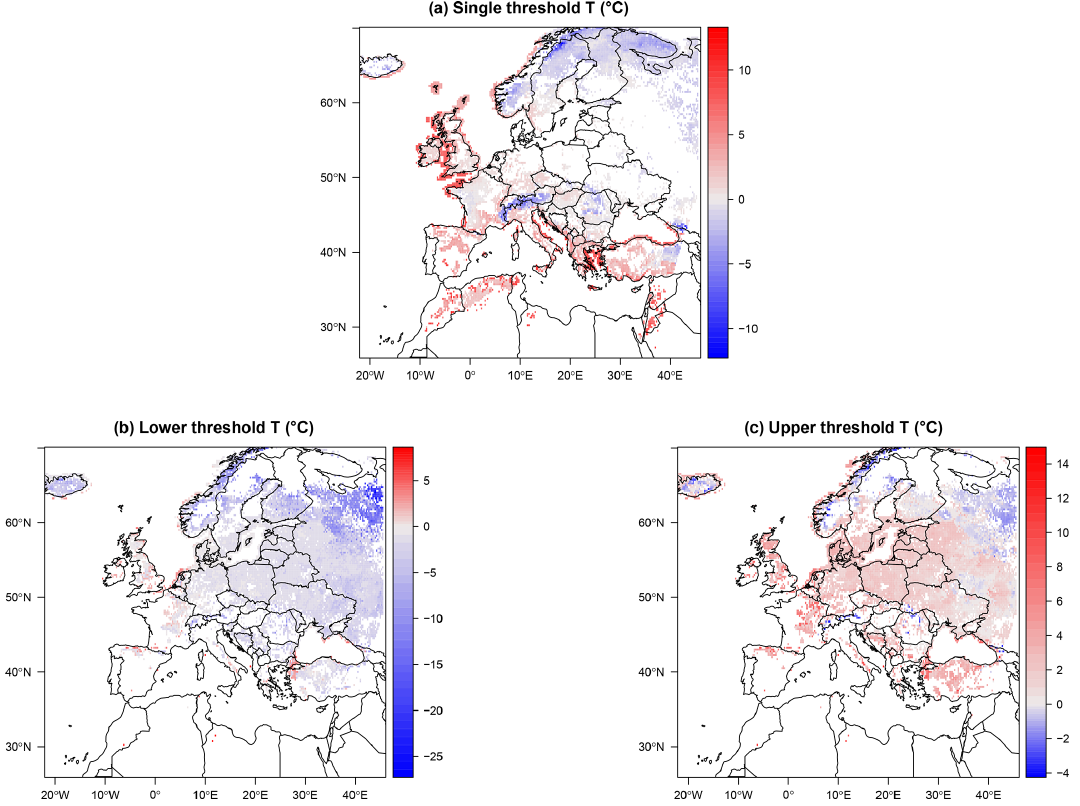
Figure 2. Threshold temperatures optimized for segmented logit-linear regression, according to Eq. (A11), using ERA5 data. (a) Locations with a single threshold temperature. (b, c) Locations with double threshold temperatures, with lower thresholds (b) and upper thresholds (c) also